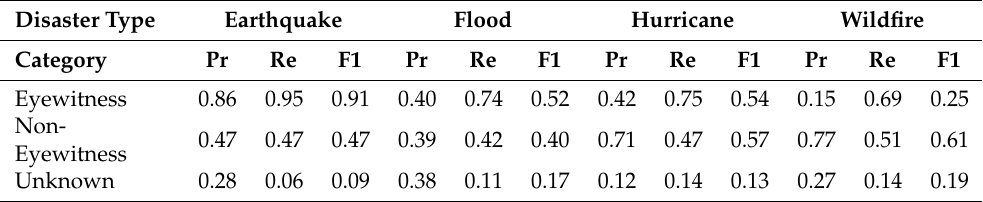
Table 10. Experiment-1: Manual Classification (F-Scores) with New